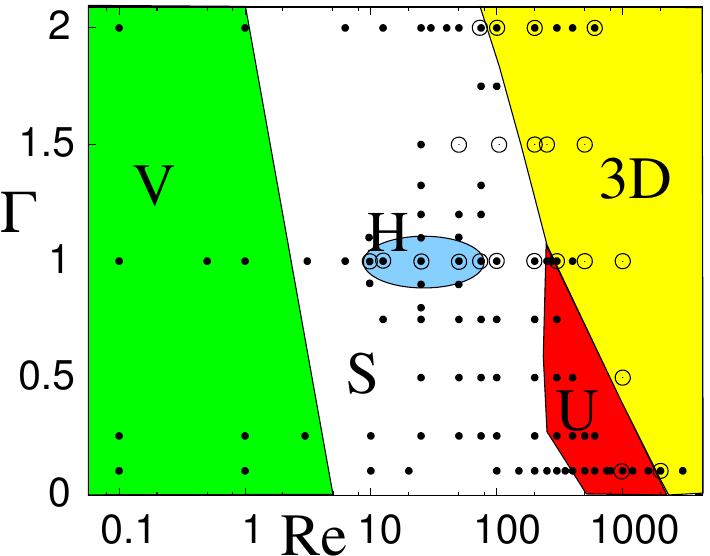
Figure 1. Phase diagram of the regimes for the flow around a torus: • indicate axisymmetric runs, ◦ three-dimensional simulations. V : Stokes regime; S : steady regime; H : Hill regime; U : unsteady regime; 3D : three-dimensional regime. Note that the runs at Re < 0.1 are not reported in the figure to avoid the squeezing of the regions to the